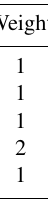
Table 2. The weight setting for each feature in the MetSignal algo- rithm.